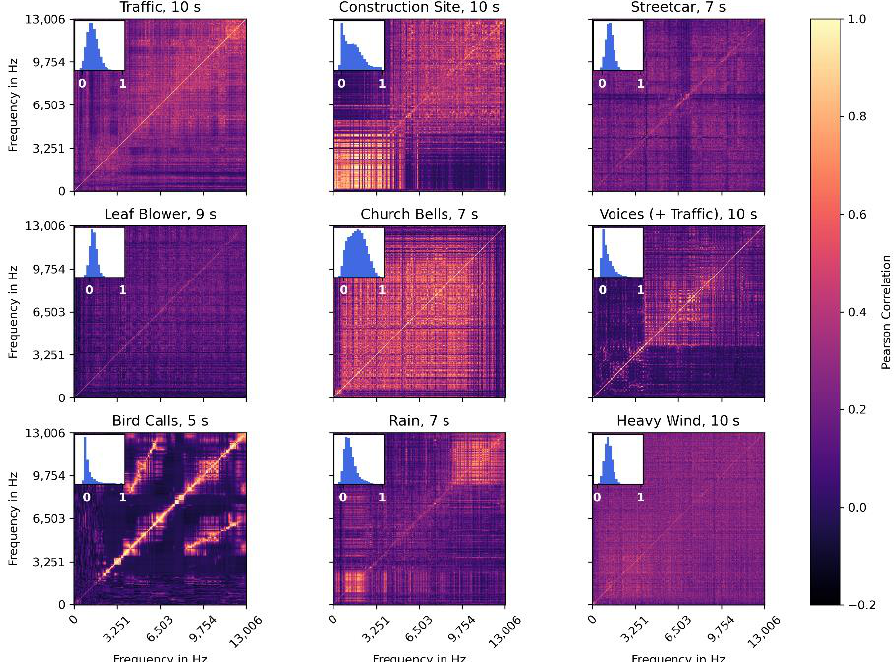
Figure A1. Percentage of land use area (as defined by Ruhr Regional Association [41]) in a 50m radius buffer around each recording station. Depicted are the ten largest land use types, which in total occupy more than 94% of the 50m buffer area.